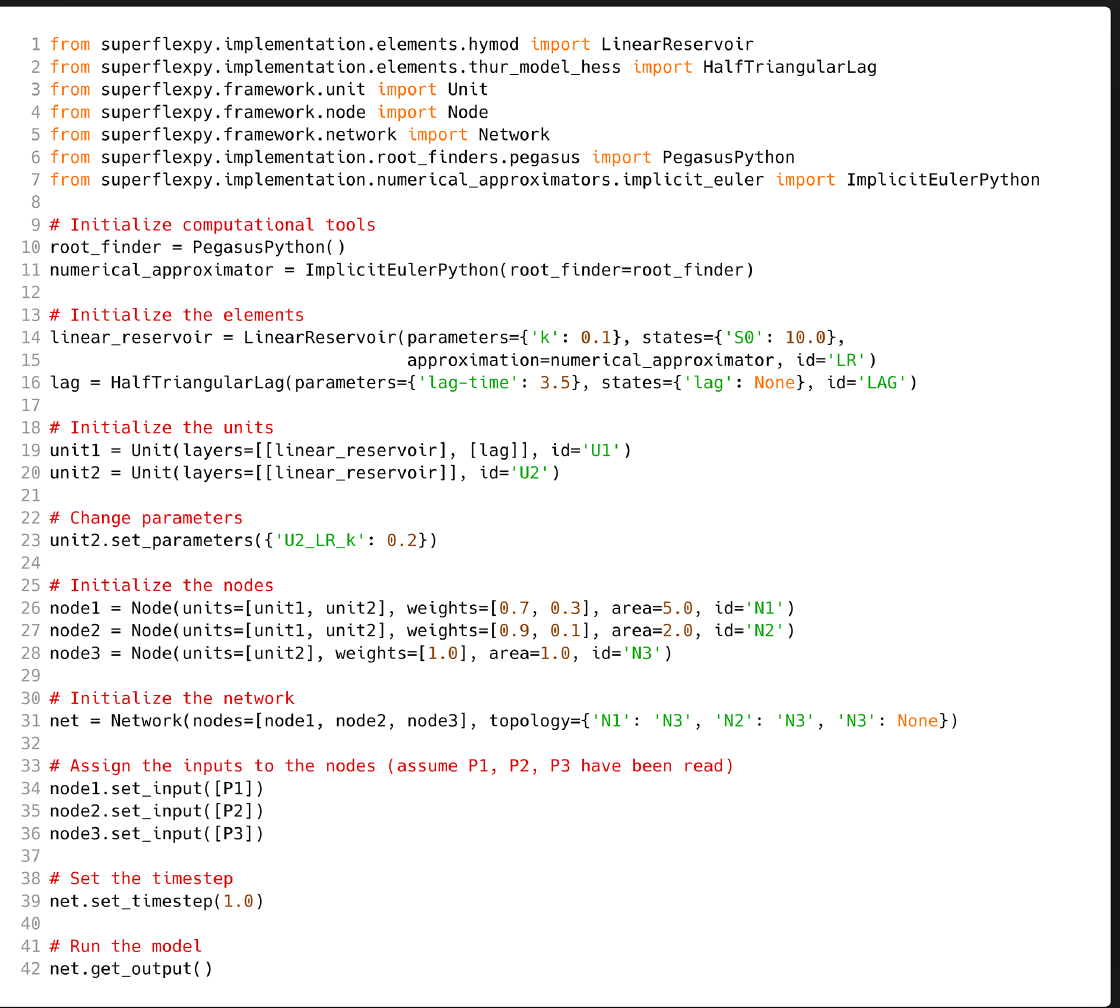
(Line 31). The connectivity is defined indicating, for each node , the node downstream of it. A network iden- tifier is not specified (as only a single network can be